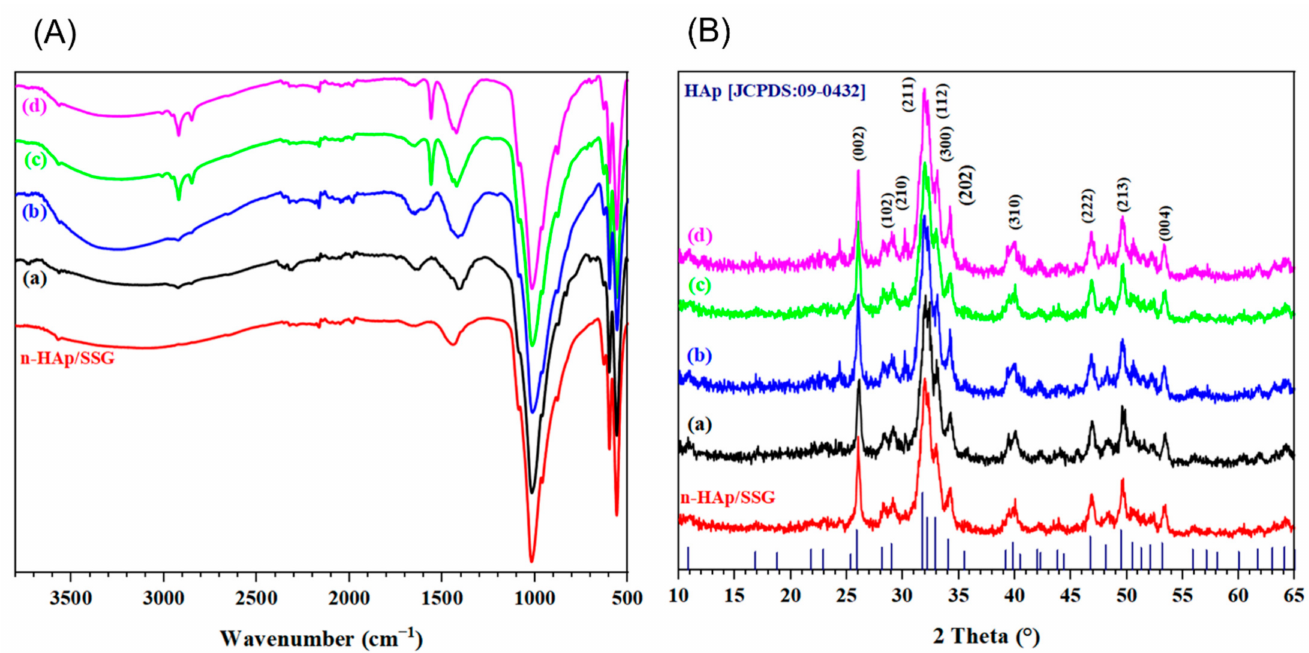
Figure 2. ATR-FTIR ( A ) and XRD patterns ( B ) of consolidated samples. (a) HAp-Aq, (b) HAp-Me, (c) HAp-Et, and (d)